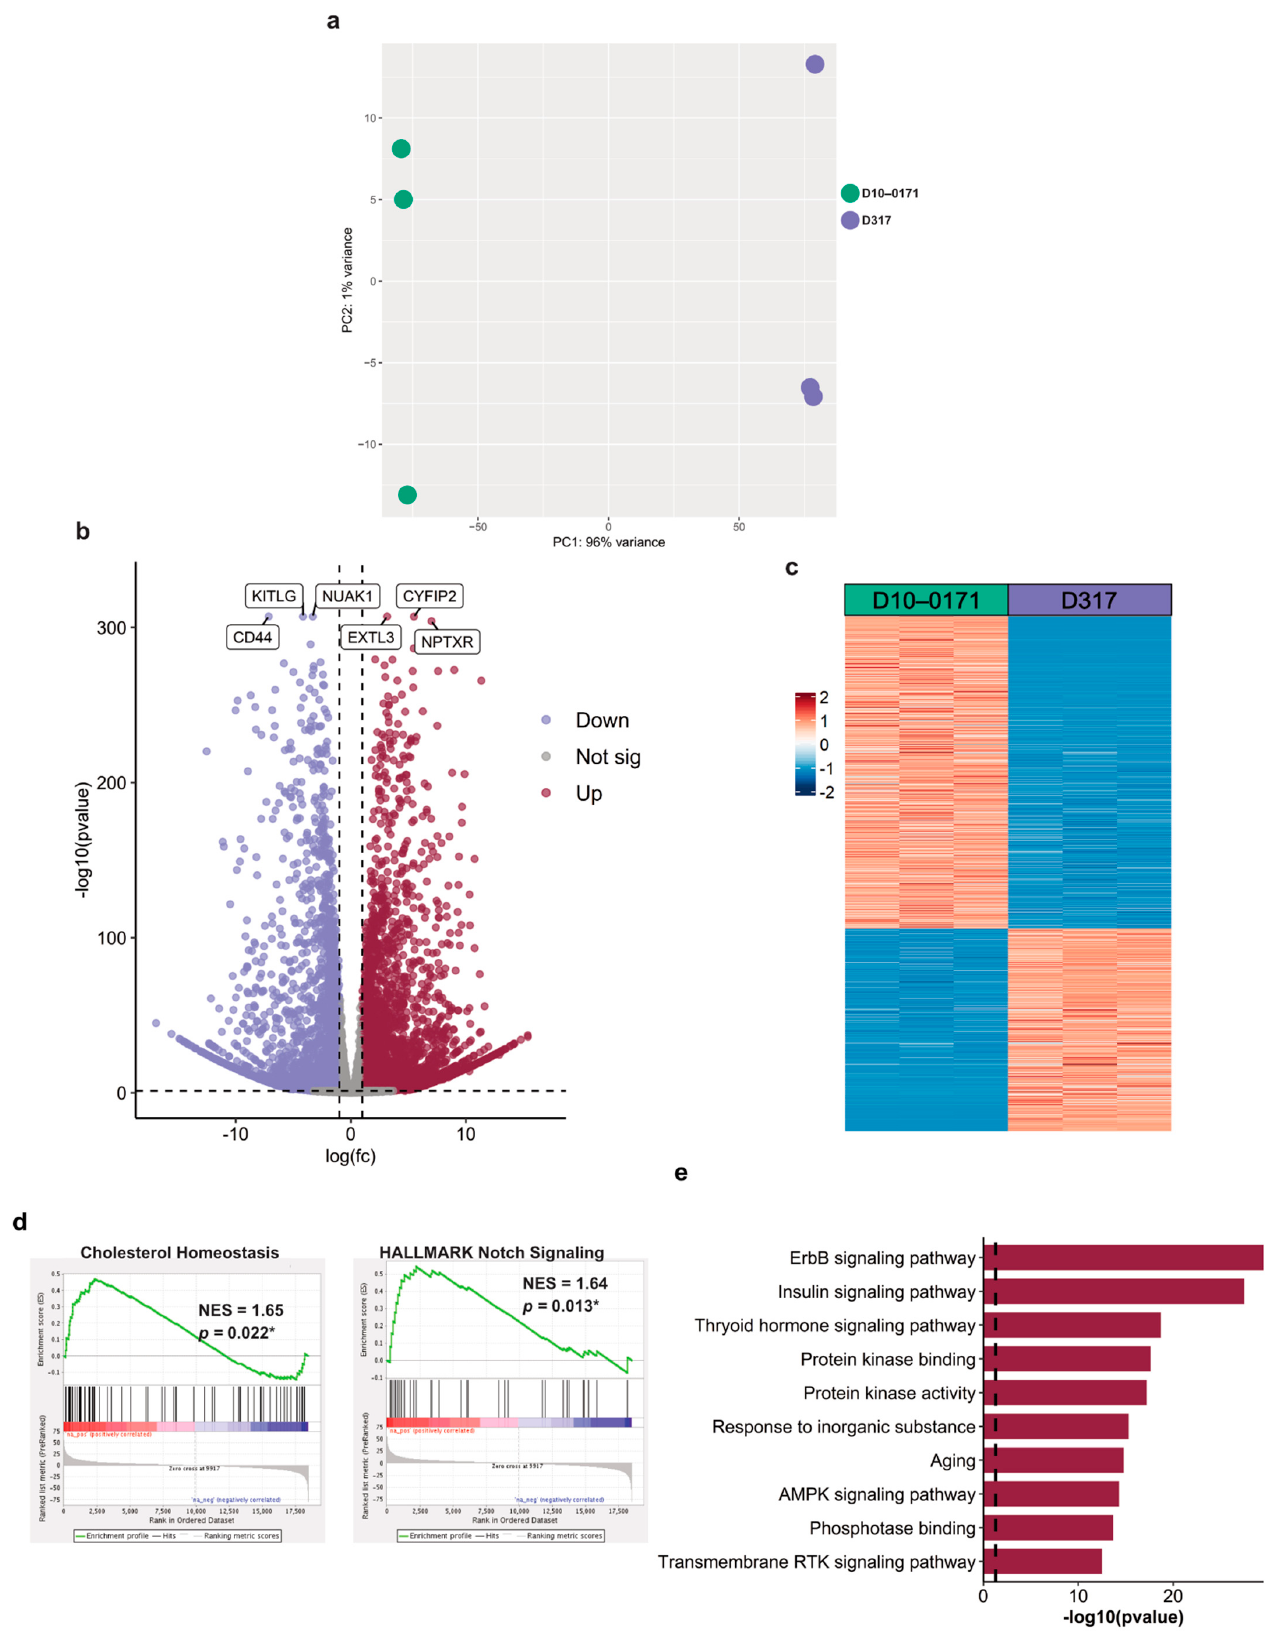
Figure 3. D10-0171 and D317 cells exhibit molecular differences. ( a ) PCA plot of transcriptomic data demonstrates separation of D10-0171 and D317 GSCs. ( b ) Volcano plot of differentially